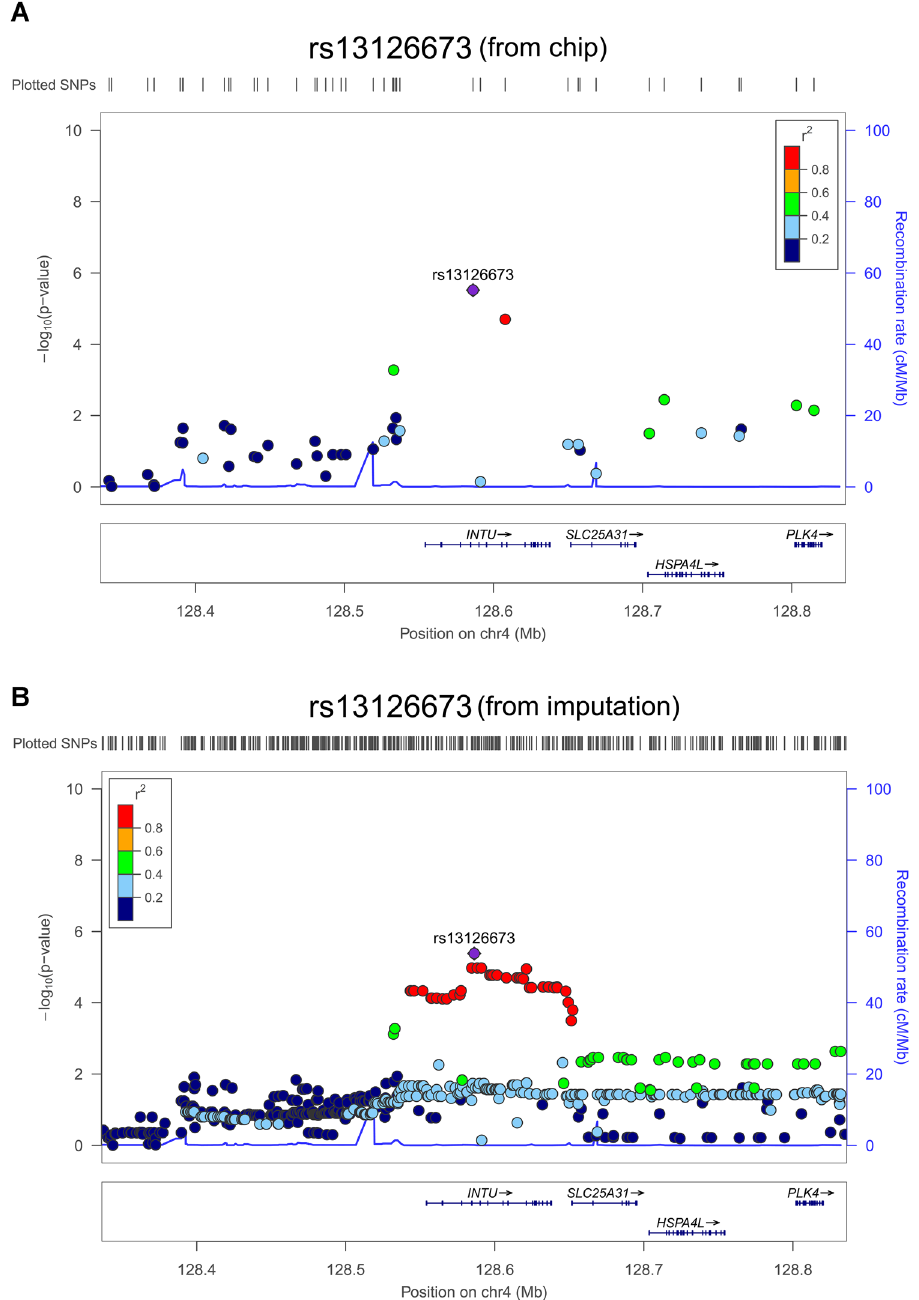
Figure 6. Association plots for the INTU locus. ( A ) Regional association plot for the INTU locus on chromosome 4 with gene annotation imposed. Each SNP was plotted to represent its chromosomal location (x-axis) and − log10 P value (y-axis) for the trend test from the GWAS data. ( B ) After imputation, the SNPs were plotted, and the colors denote the strength of linkage disequilibrium of SNPs to